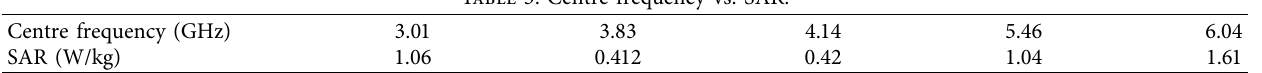
Figure 16: SAR analysis at various resonating frequencies. (a) 3.01GHz. (b) 3.83GHz. (c) 4.14GHz. (d) 5.46 GHz. (e) 6.04GHz. Table 3: Centre frequency vs. SAR.